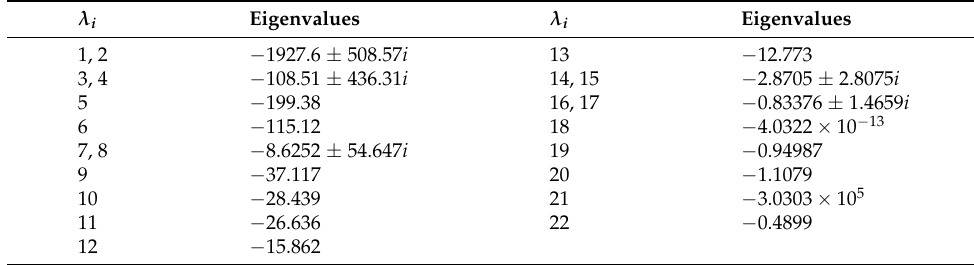
Table 3. Eigenvalues of the system.